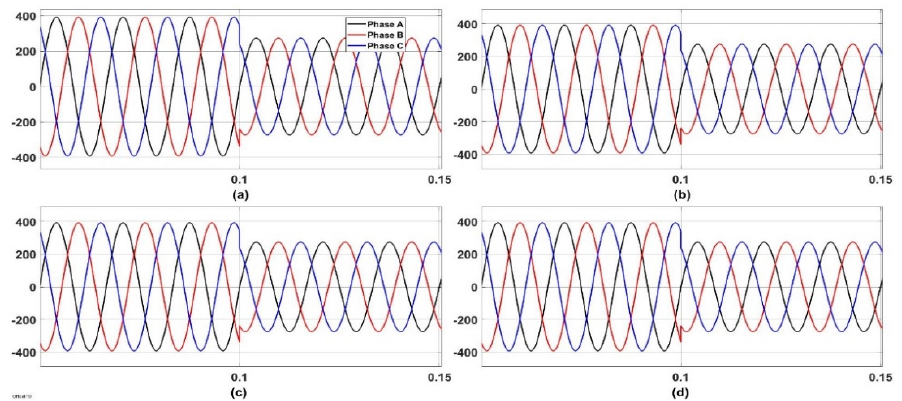
Figure 16. Three-phase pcc voltages in a balance dip in the case of ( a ) 2L- αβ , ( b ) 3L- αβ , ( c ) 2L-dq and ( d ) 3L-dq .